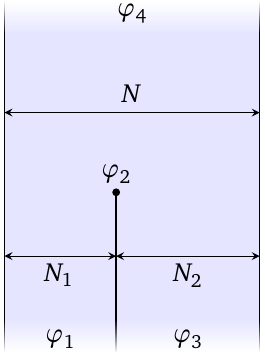
Figure 2: The picture illustrates the geometry of the flat-pants domain. It corresponds to a concatenation of an upper vertical semi-infinite strip of width N and two lower vertical semi-infinite strips of widths N , N , separated by a slit. The LBF can be 1 2 constructed from CFT correlation functions with primary fields at boundary points of this domain. The fields ϕ , ϕ and ϕ are localised at the infinitely-remote ends of 1 3 4 the pants’ legs, whereas the insertion point of ϕ is the top of the 2